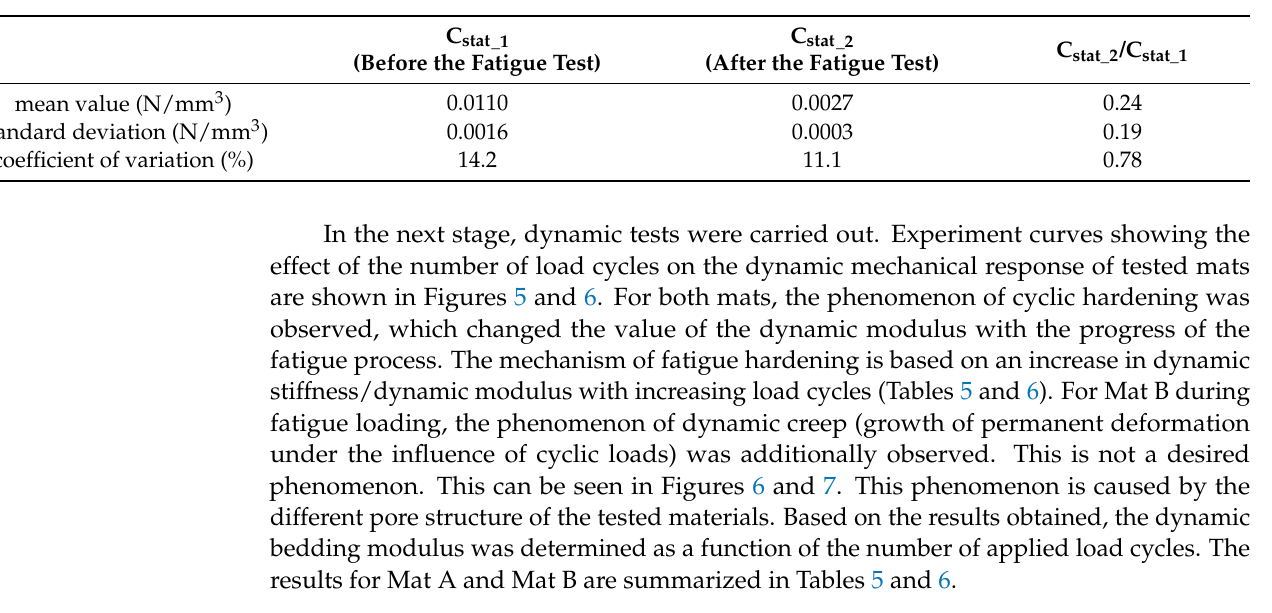
Figure 6. Experimental curves (specimen 2) showing the effect of the number of load cycles on the dynamic mechanical response (C dyn ), cyclic hardening and dynamic creep of Mat B.